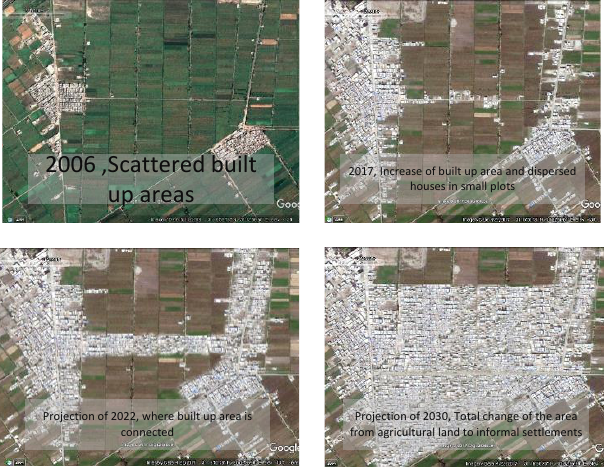
Figure 9: Development and Projection of informal settlement growth in Al-Maamoura - Source: